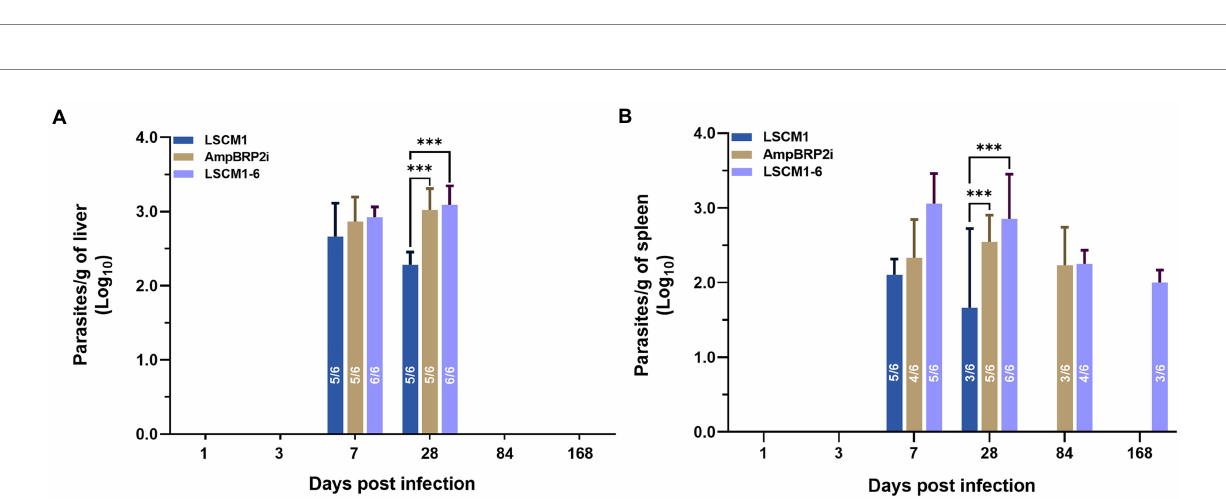
FIGURE 6 Parasite burdens in the liver and spleen samples of BALB/c mice infected with the L. martiniquensis LSCM1, AmpBRP2i, and LSCM1-6 stationary phase promastigotes at 1, 3, 7, 28, 84, and 168 dpi determined by limiting dilution assay. (A) Parasite load quantified from the liver of infected mice. (B) Parasite load quantified from the spleens of infected mice. Statistically significant differences among the three groups are indicated as follows: *** = p < 0.001. The number inside the columns is the number of positive mice per total mice sacrificed in each